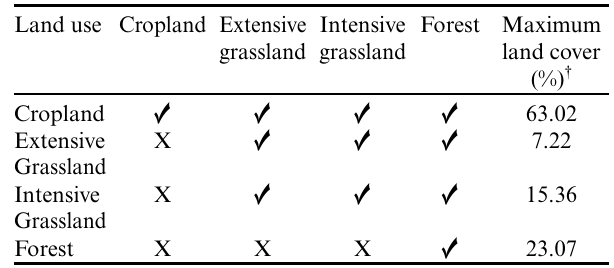
Table 3. Transition rules for the optimization and maximum land cover of each land use. A ✓ means that the land use types can be converted into one another; an X means that a conversion is not allowed. For example, extensive grassland can remain extensive or can be transformed into intensive grassland or forest, but it cannot be transformed into cropland.